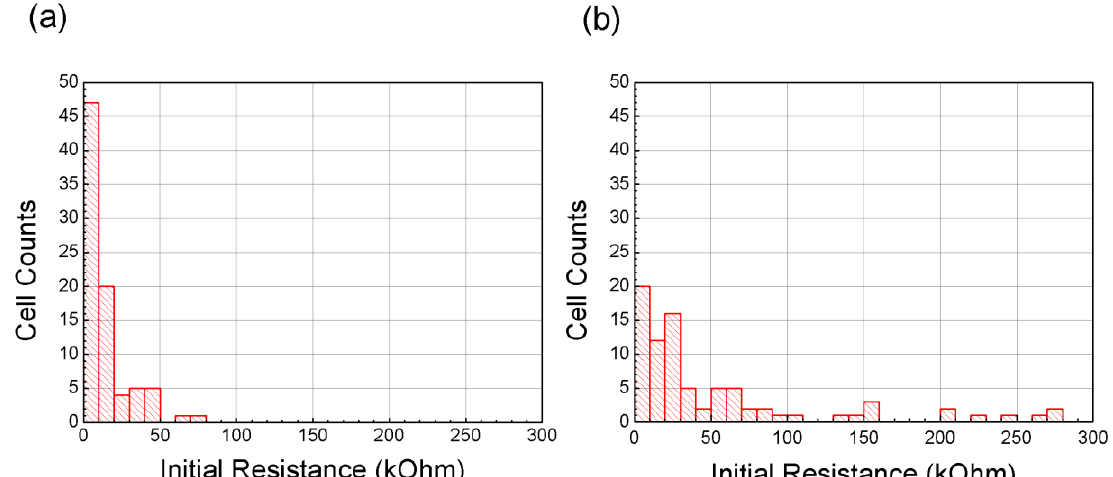
-decorated CNT 2